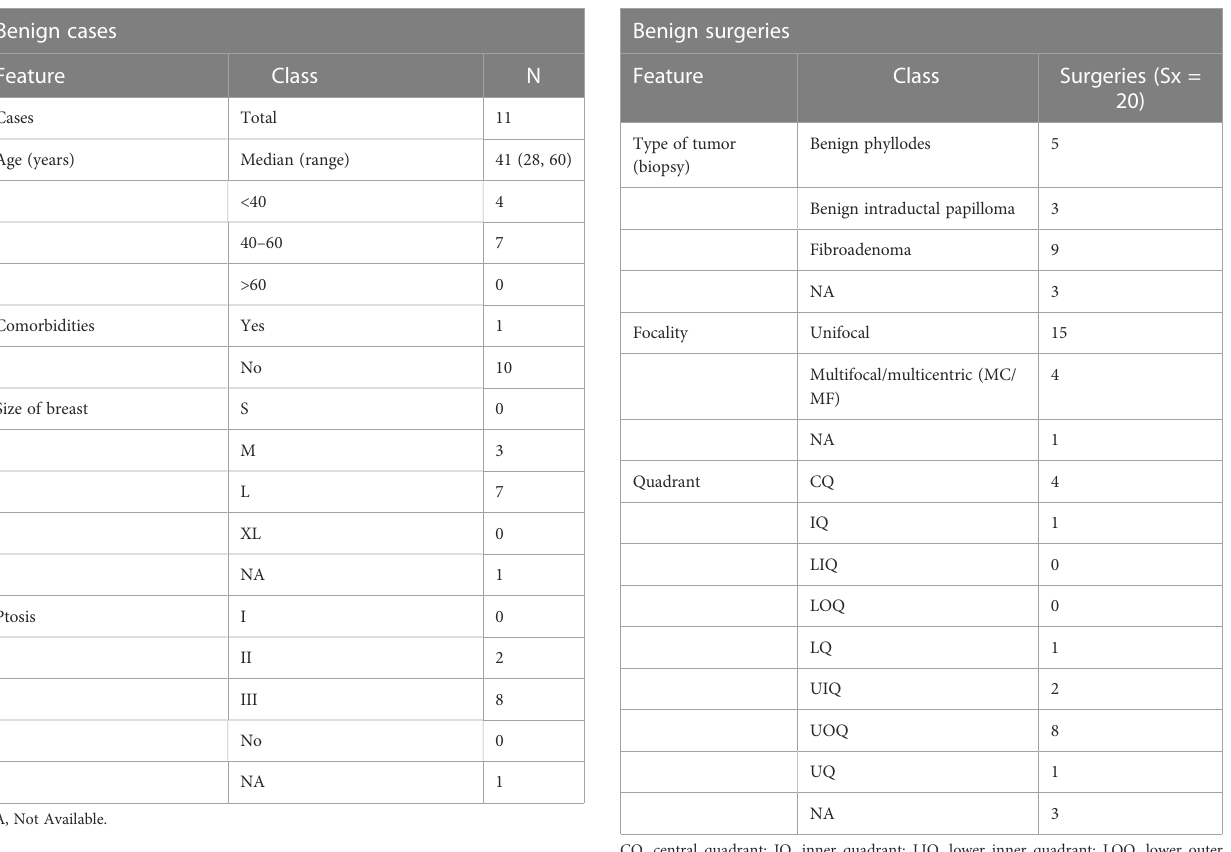
TABLE 4 Demographic features of patients with benign breast disease. TABLE 5 Clinical features of surgeries for benign